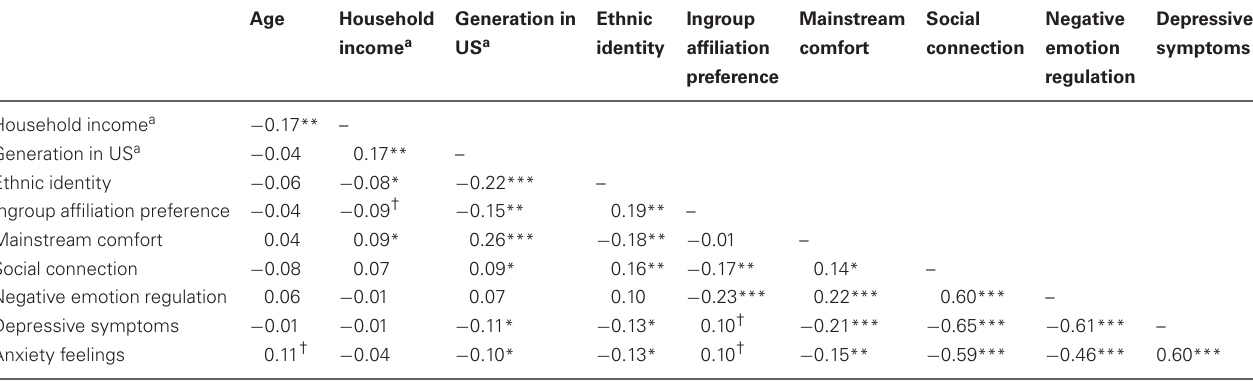
Table 2 | Pearson or Spearman correlations among study variables for all participants.